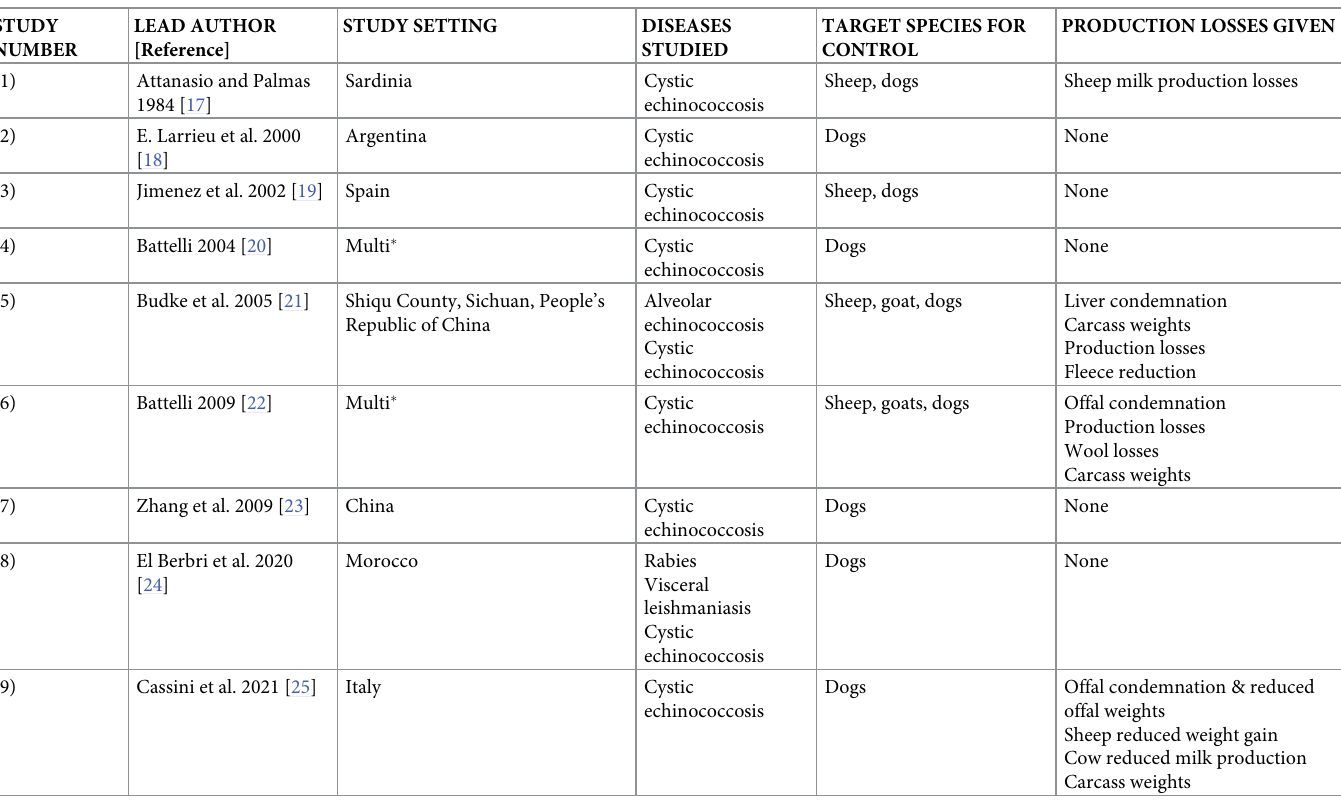
Table 1. Summary characteristics of economic evaluation studies for the control of Cystic